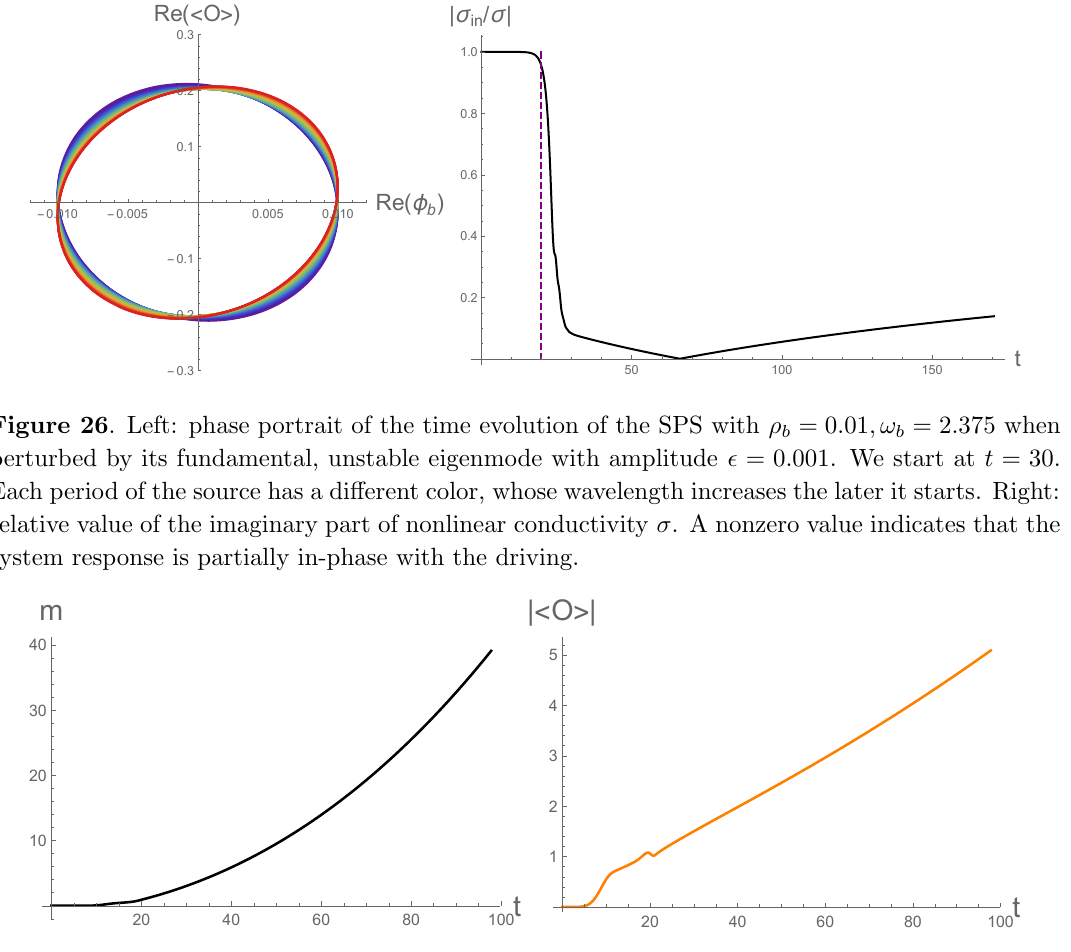
Figure 27 . Time evolution of the energy density (left) and vev modulus (right) for a quench process of the form (3.1) with (cid:15) = 0 : 09 ; ! b = 2 and (cid:12) =